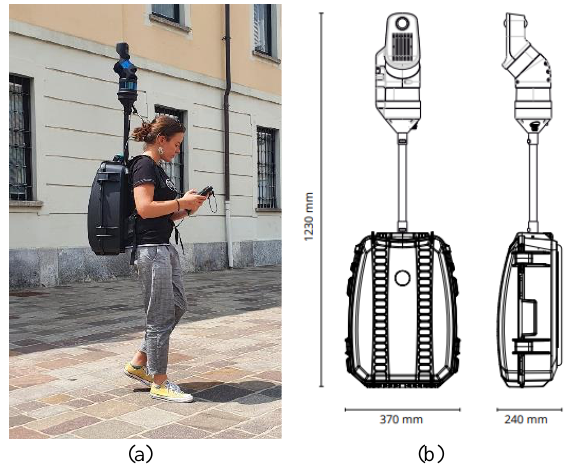
Figure 2. (a) The operator wearing Backpack Laser Scanner IMMS Heron MS Twin Color produced by Gexcel S.r.l. (BS); (b) Technical drawing of the instrument. Image modified from www.gexcel.it